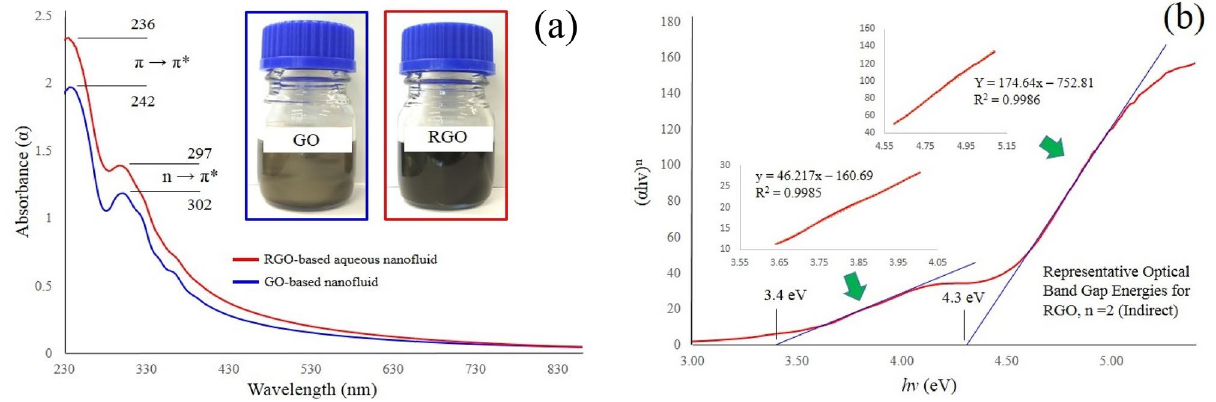
Figure 4. ( a ) UV–Vis absorption spectrum of GO and RGO based aqueous nanofluids and ( b ) Tauc plot of ( αhv ) n versus photon energy ( hv ) for a RGO based aqueous